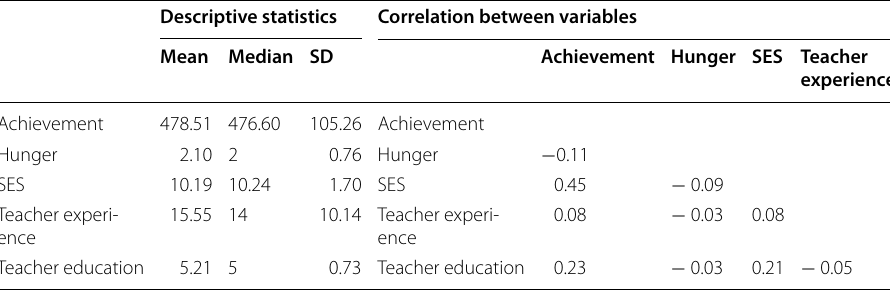
All of the correlations are statistically significant